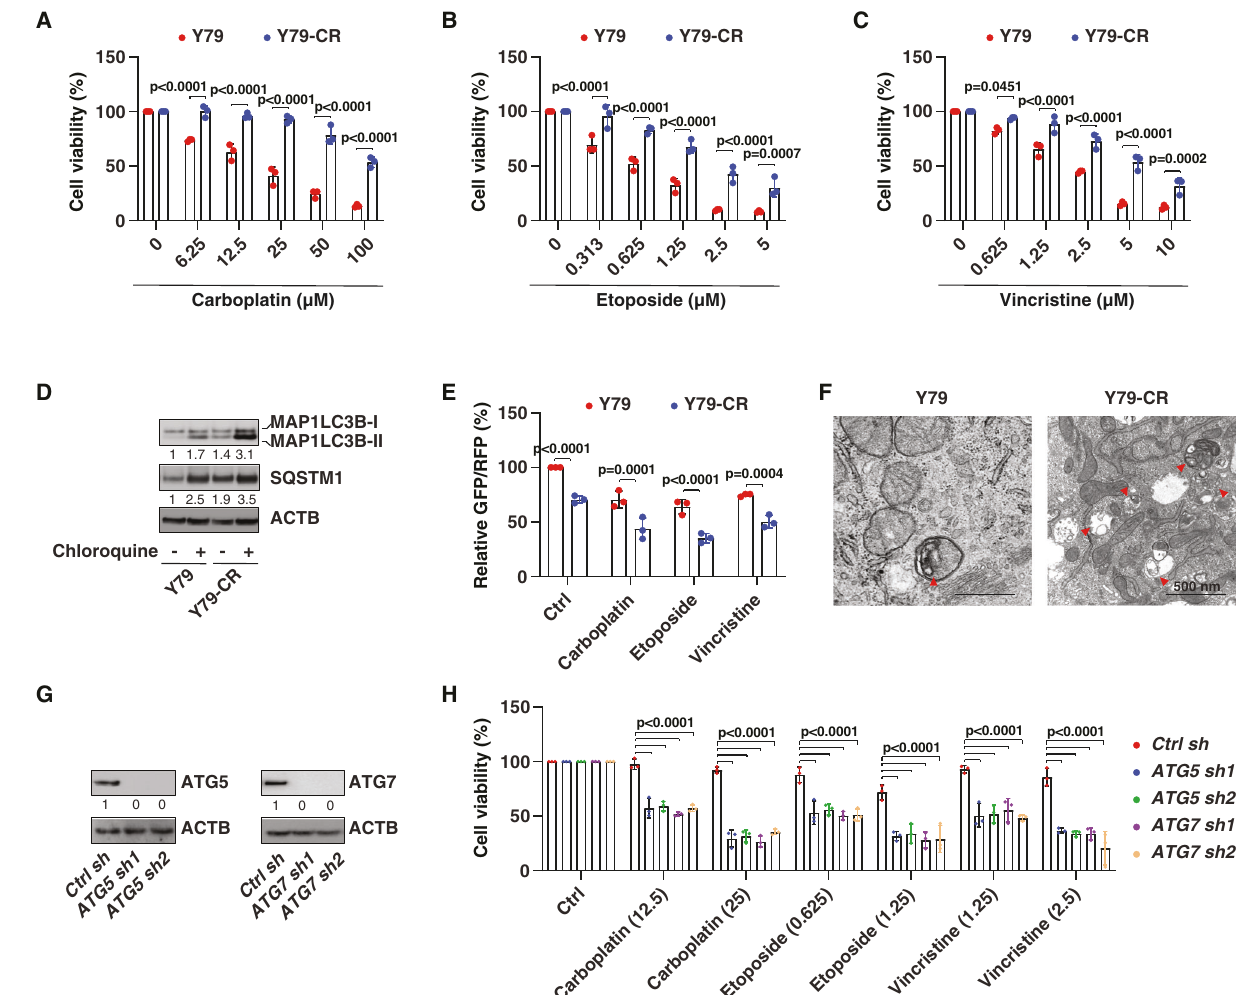
Fig. 1 The upregulation of autophagy promotes multi-drug resistance. A – C Y79 and Y79-CR cells were treated with the indicated chemotherapy drugs for 24 h, and cell viability was assayed (two-way ANOVA with Tukey ’ s multiple comparisons test; data are presented as mean ± SD; n = 3 biologically independent samples). D Western blot analysis of protein expression in Y79 and Y79-CR cells in the absence or presence of chloroquine (50 µM) treatment for 6 h. E The GFP-LC3-RFP-LC3 Δ G probe was used to measure autophagic fl ux in Y79 and Y79-CR cells following treatment with carboplatin (25 µM), etoposide (1.25 µM), or vincristine (2.5 µM) for 6 h (two-way ANOVA with Tukey ’ s multiple comparisons test; data are presented as mean ± SD of relative GFP:RFP ratio; n = 3 biologically independent samples). F The representative transmission electron microscopy image of autophagic vacuoles (red arrowheads) in Y79 and Y79-CR cells. Bar: 500 nm. G Western blot analysis of protein expression in ATG5 - or ATG7 -knockdown Y79-CR cells. H Cell viability analysis of the indicated Y79-CR cells following treatment with carboplatin (12.5 and 25 µM), etoposide (0.625 and 1.25 µM), or vincristine (1.25 and 2.5 µM) for 24 h (two-way ANOVA with Tukey ’ s multiple comparisons test; data are presented as mean ± SD; n = 3 biologically independent Surprisingly, Y79-CR cells were also resistant to etoposide (Fig. 1B) and vincristine (Fig. 1C), indicating that Y79-CR cells have a multi- drug resistance (MDR) mechanism. Because autophagy is one of the main mechanisms of parent cells, the protein level of autophagosome marker MAP1LC3B (microtubule associated protein 1 light chain 3